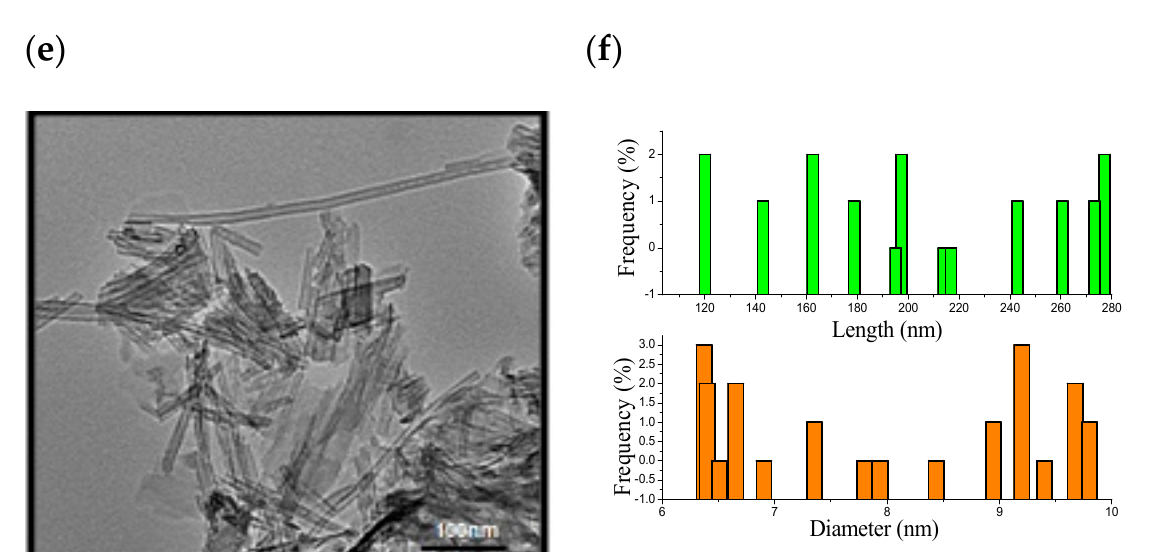
Figure 4. SEM images for ( a ) undoped membrane, ( b , c ) doped membrane (PVA/PEO/PO 4 TiO 2 -1) surface and cross-section ( d ) EDX analysis for PO 4 TiO 2 , ( e ) TEM image for PO 4 TiO 2 nanotubes and ( f ) the frequency distribution plot of PO 4 TiO 2 nanotubes size from TEM image.